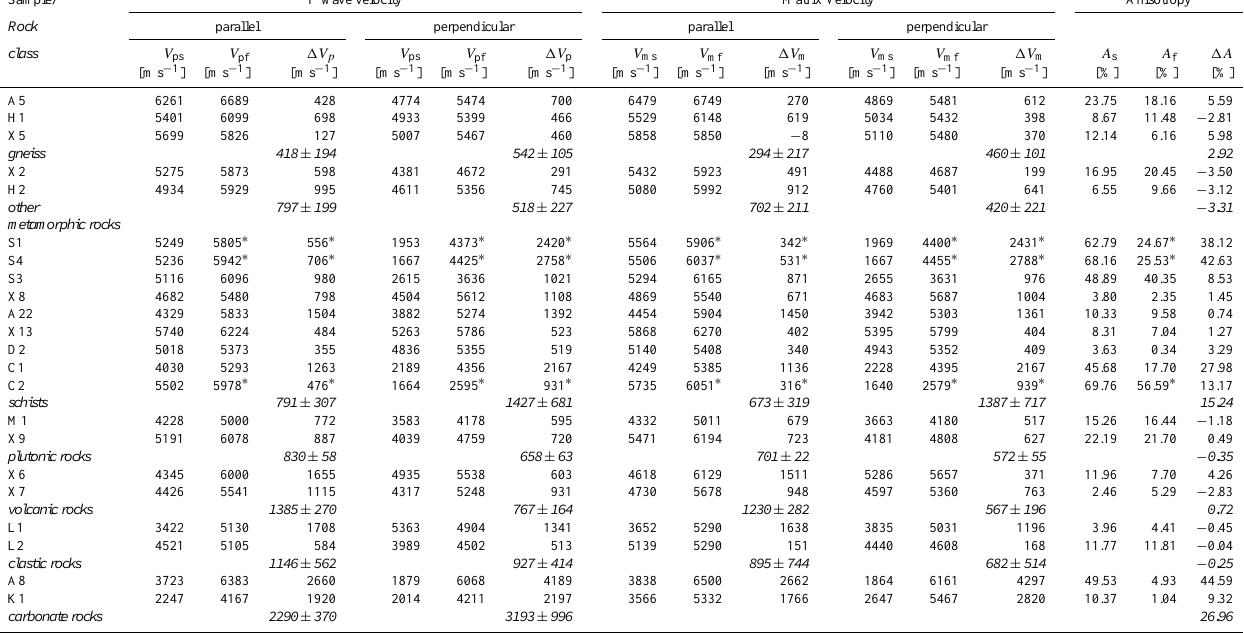
Table 2. Rock samples classified into lithological groups and seismic properties. The table shows p-wave velocity of a saturated unfrozen ( v ps ) and a frozen ( v pf ) sample, p-wave velocity increase due to freezing ( 1v p ) , matrix velocity of a saturated unfrozen ( v ms ) and a frozen ( v mf ) sample, matrix velocity increase due to freezing ( 1v m ) , anisotropy of a saturated ( A s ) and a frozen ( A f ) sample and the decrease of anisotropy due to freezing ( 1A